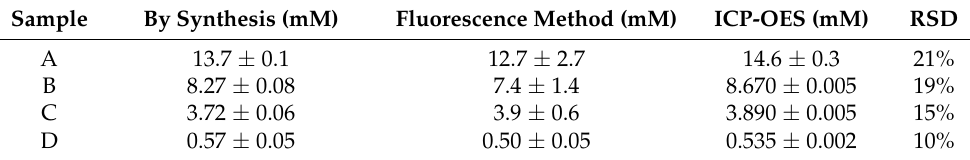
Table 3. Test solutions with different initial concentration of